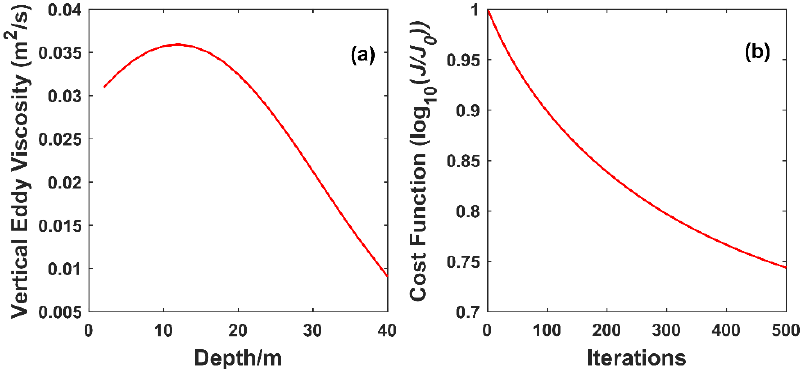
Figure 11. The left panel ( a ) shows the inverted distributions of the VEVC in the practical experiment. The right panel ( b ) is the cost function in the practical experiment.